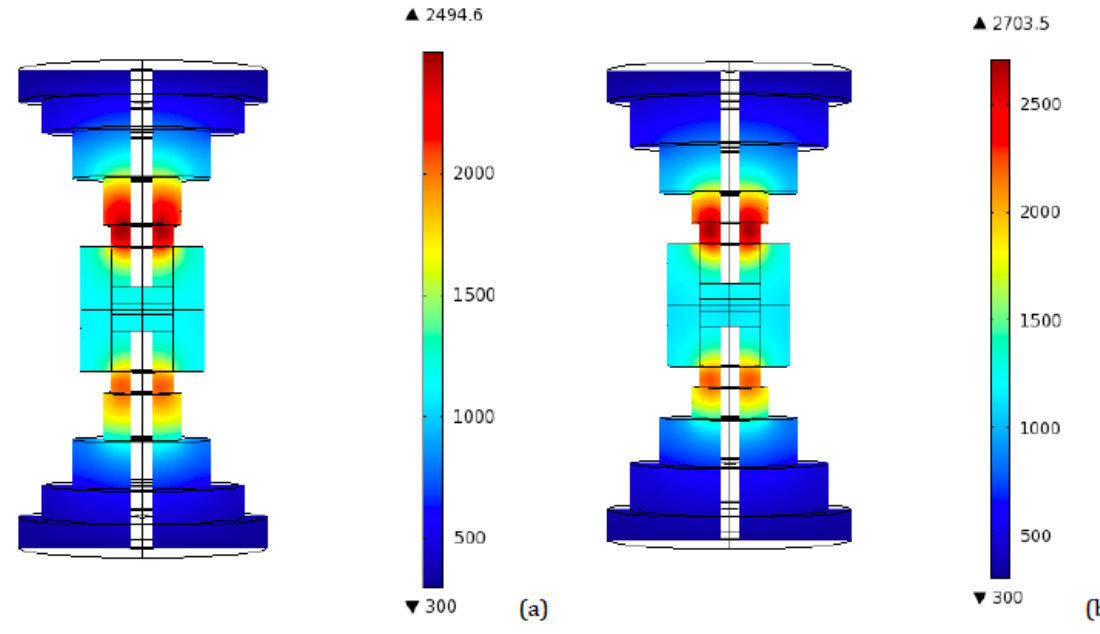
Figure 10. Peak temperature distribution—Resistive contact—Height influence comparison for a three disks configuration (Radii: 65, 45, and 25 mm). ( a ) Heights: 20, 30, and 30 mm from the top; ( b ) Heights: 30, 30, and 20 mm from the